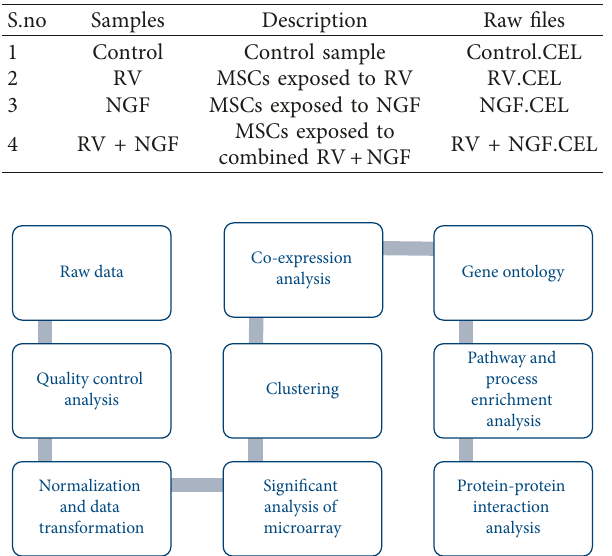
Table 1: Four samples that were used for microarray gene ex- pression analysis.